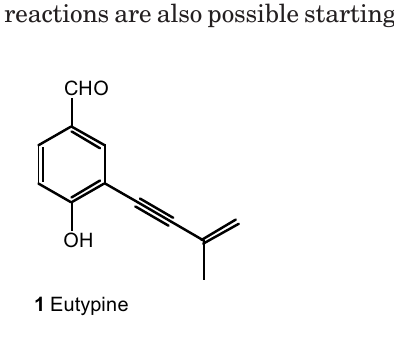
Fig. 1 Chemical structure of eutypine and sterehirsutinal.